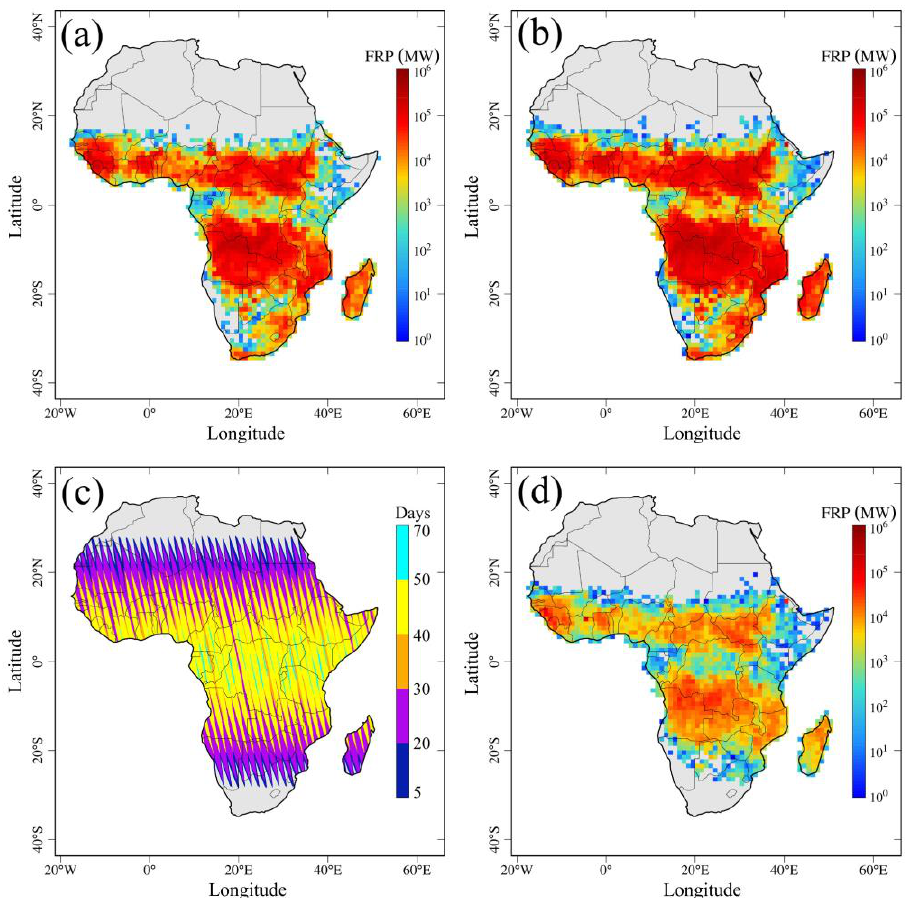
Figure 9. Yearly summed MODIS and VIIRS daytime FRP at a 1° grid across Africa in 2017. ( a ) The observed MODIS FRP, ( b ) the observed VIIRS FRP in the MODIS-sensed areas (outside MODIS swath gaps), ( c ) the total number of days without Aqua MODIS observations (inside MODIS swath gaps), and ( d ) the VIIRS FRP observed inside MODIS swath gaps.